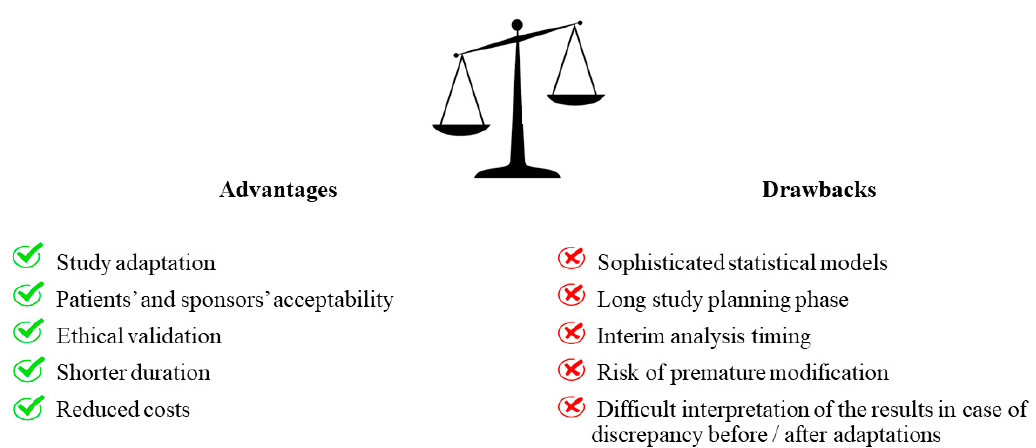
Figure 2. Advantages and drawbacks of adaptive